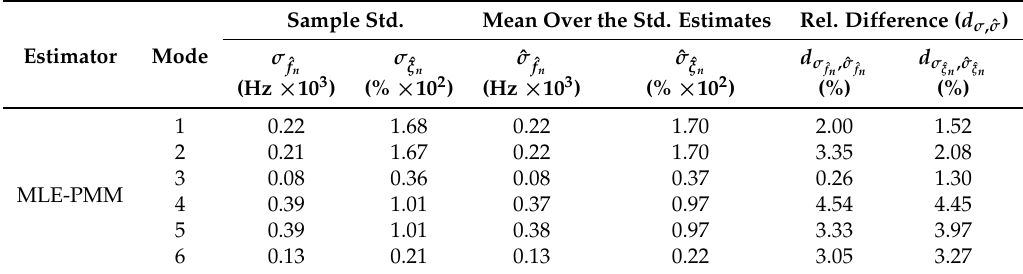
Figure 20. Monte Carlo simulation results for the identified natural frequencies and damping ratios: sample (black line) and predicted (red line) means and standard deviations of natural frequencies ( a ) and damping ratios ( b ) provided by the proposed MLE-PMM method after 20 iterations. Table 9. Monte Carlo simulation results obtained from the simulated EMA of the five-DOF system: comparison between the sample standard deviations and those predicted in a typical Monte Carlo run with the proposed MLE-PMM after 20